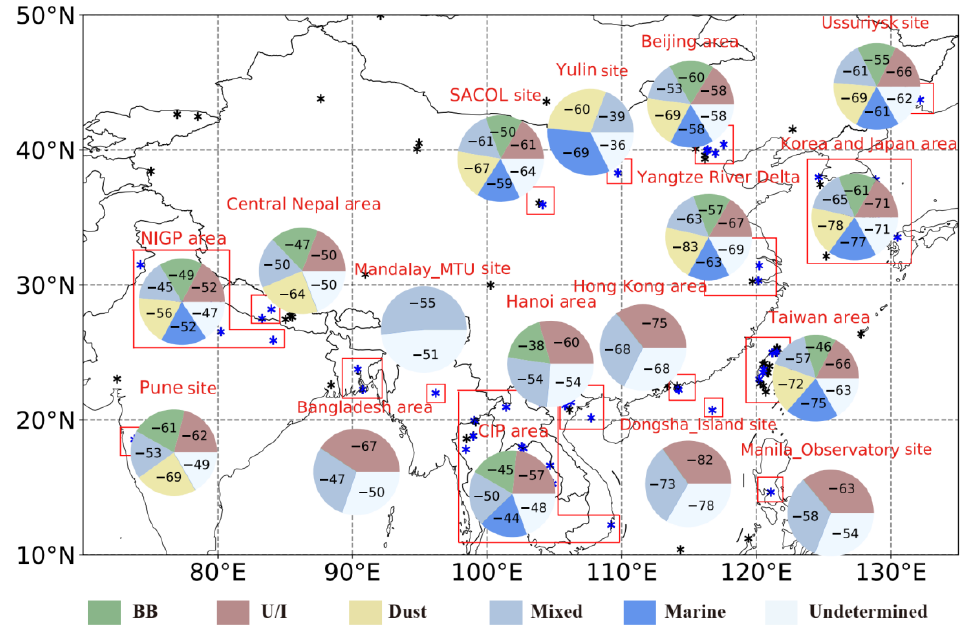
Figure 11. The same as Figure 9 but for the ARFE TOA (Unit: W/m 2 /AOD 550nm ).